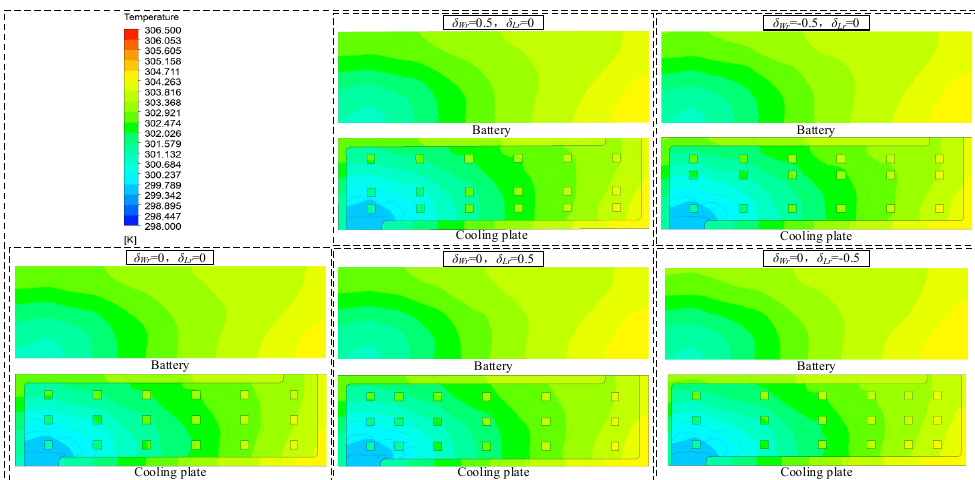
Figure 14. Temperature contour of battery and cooling plate with various pin-fin distributions.